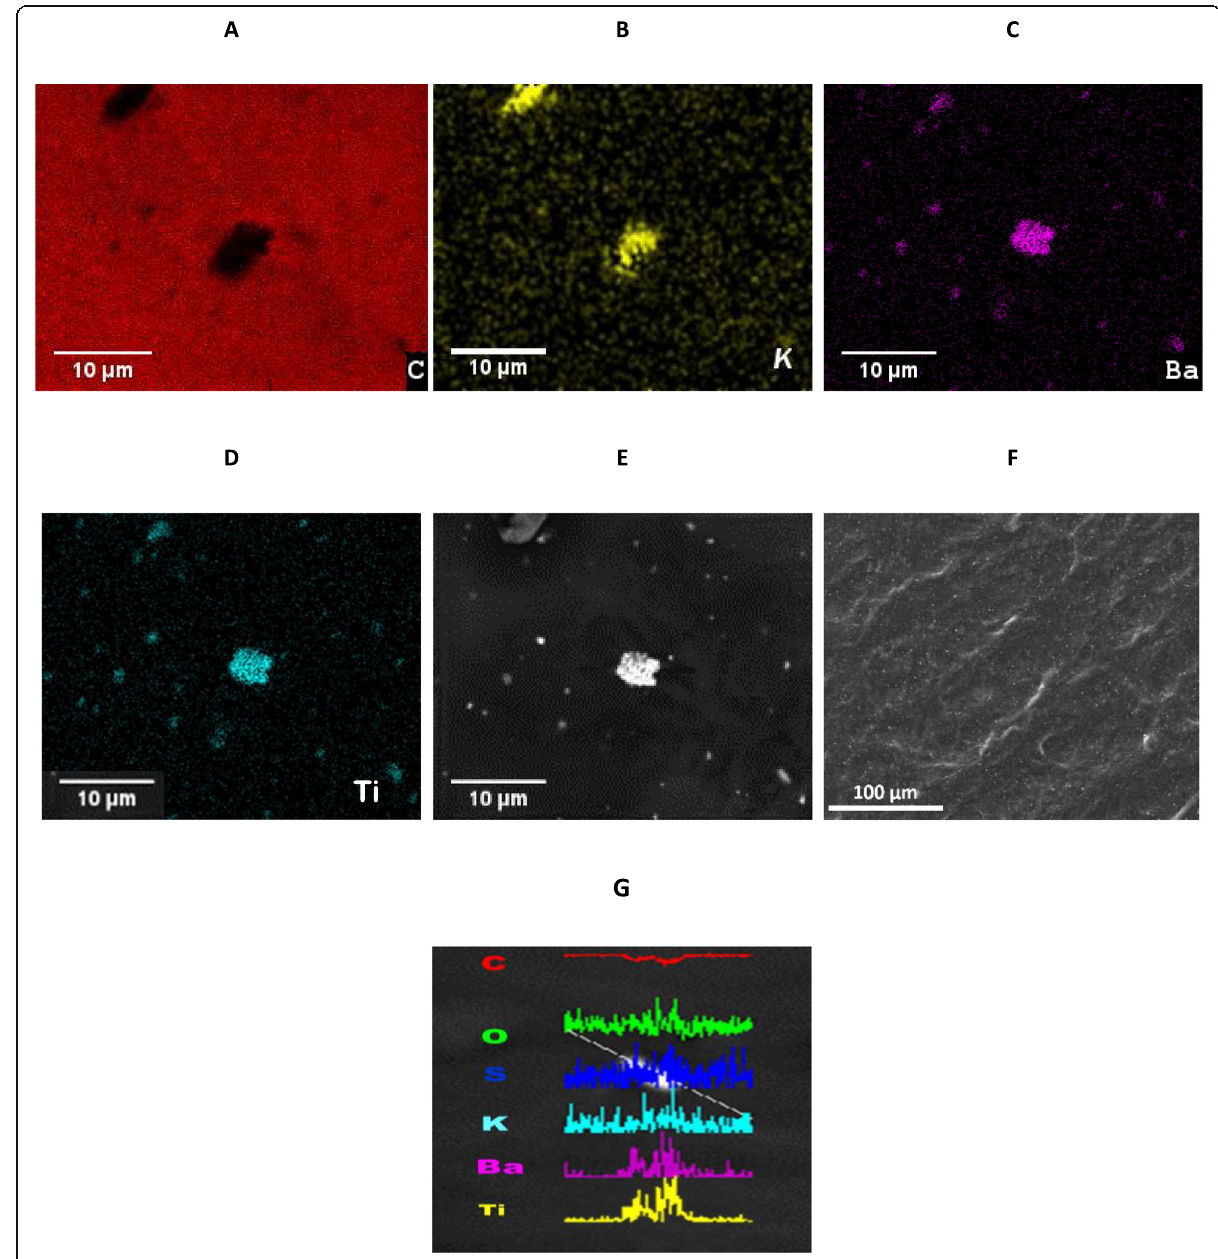
Fig. 8 EDAX of KF-BaTiO 2 nanoparticle-hydrogel composites. Images of KBT nanoparticles in PNIPAm-based hydrogel. a – c 25 kV EDAX compositional images of KBT in hydrogel. a Carbon, the indicator for the polymer. b , c , d K, Ba, and Ti the indicators for KF-BaTiO3. e Standard image without elemental filtering. f Dispersed KBT nanoparticles in PNIPAm hydrogels. EDAX show clustering of KBT nanoparticles, but adequately uniform dispersion of the nanoparticles/clusters throughout the hydrogel. The medium is homogeneous compared with the length of the RF wave at 0.01 – 1.00 MHz. g Elemental composition of KBT nanoparticle